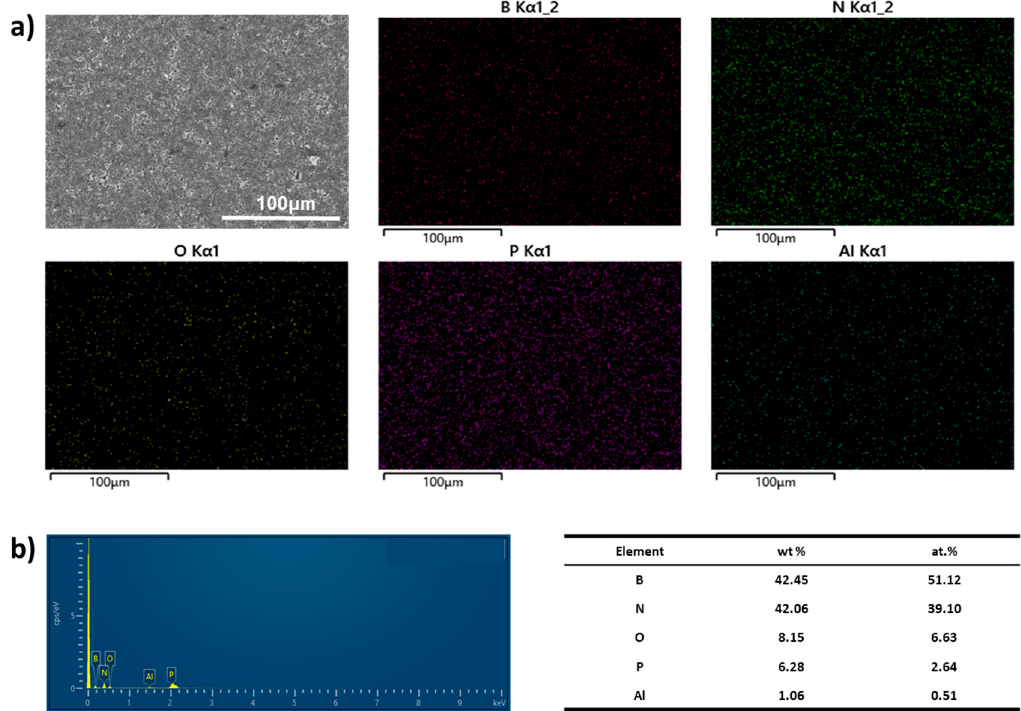
Figure 12. SEM images and EDS spectra of the h-BN coating prepared by EPD using 30 V and 10 min after immersion- annealing treatment. ( a ) Element distribution images; ( b ) element analysis chart.